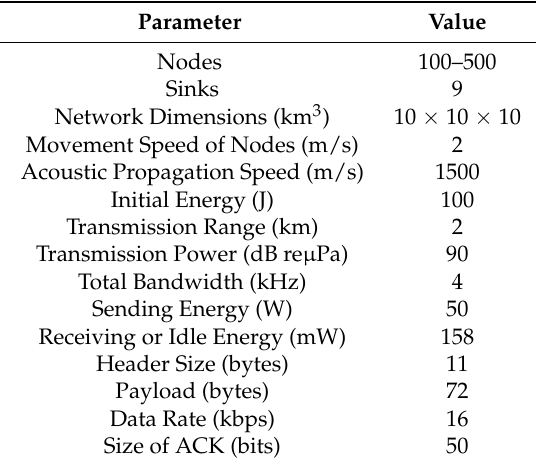
Table 2. Simulation